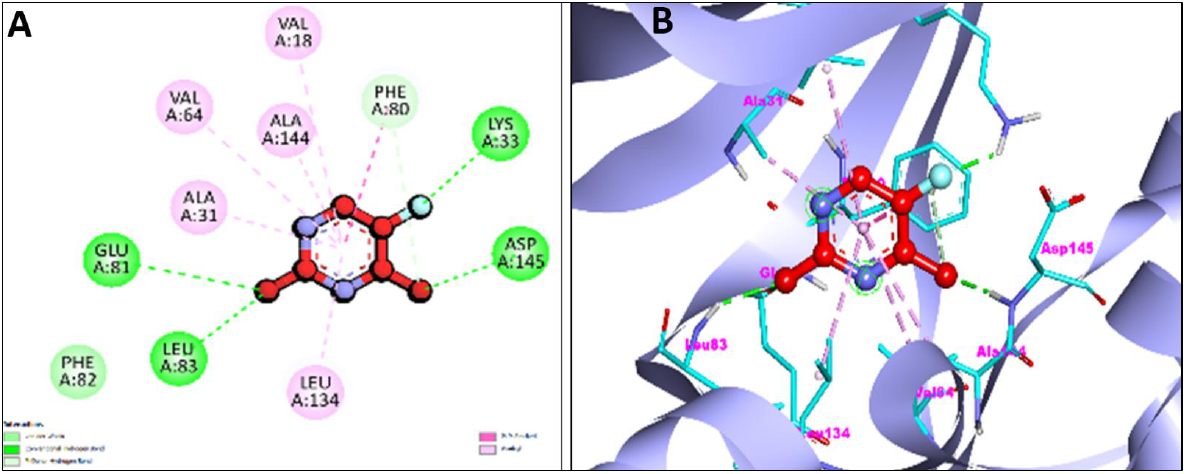
Figure 14. 2D ( A ) and 3D ( B ) representation of interaction of anti-cancerous drug fluorouracil and cyclin-dependent kinase 2 (purple color with ribbon pattern) (PDB:6GUE).